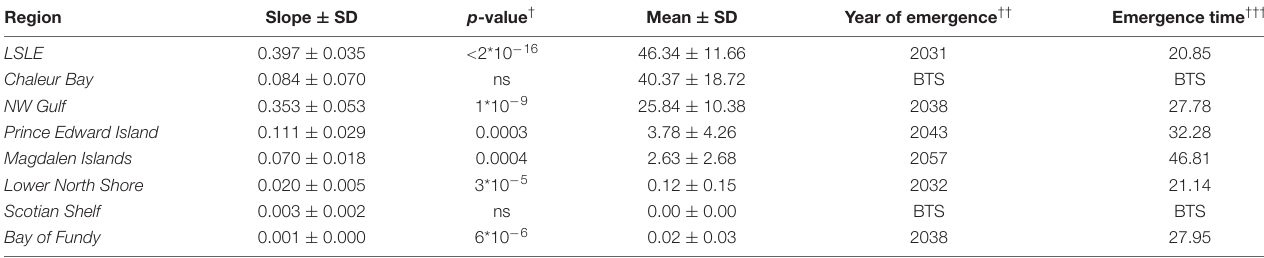
TABLE 2 | Changes in mean annual risk days predicted over the period 2001–2099 under MPI-ESM-LR RCP 8.5 within each region defined in Figure 1 (LSLE, Lower St. Lawrence Estuary): linear model slope ± Standard deviation (SD) and p -value, average sum of risk days ± SD of the contemporary period (2001–2020), year of emergence of climate signal and climate signal emergence time. Region Slope ± SD p -value † Mean ±